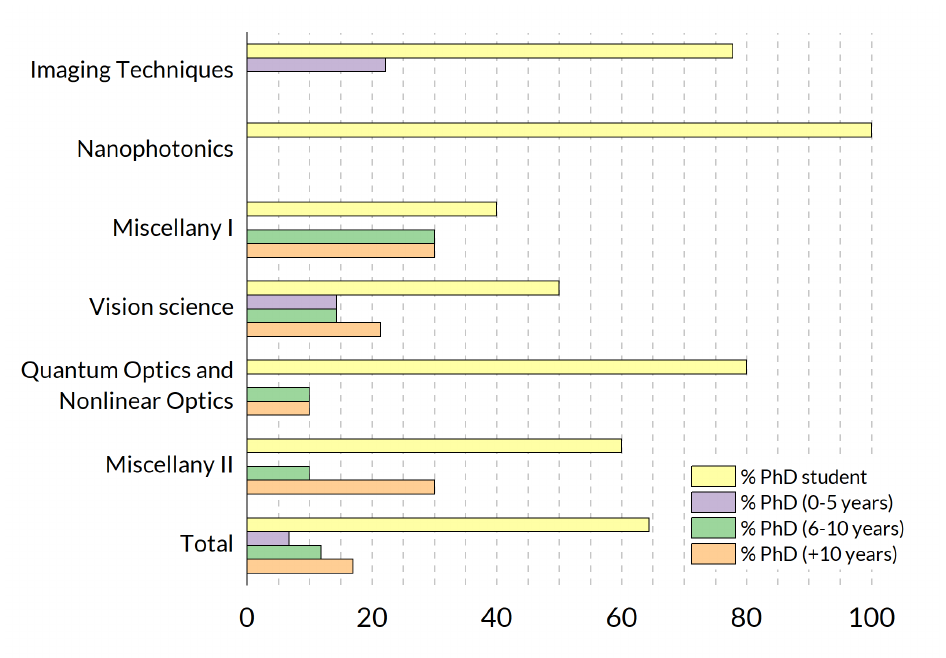
Figure 6. Career stage analysis of presenting authors in oral